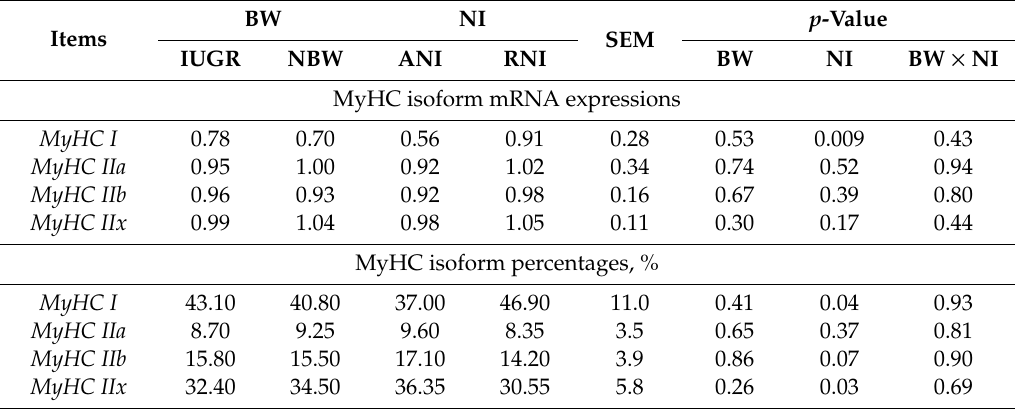
Table 8. E ff ects of the level of nutrient intake on MyHC mRNA expressions and percentage in psoas major muscles of intrauterine growth-retarded (IUGR) and normal-birth weight (NBW)